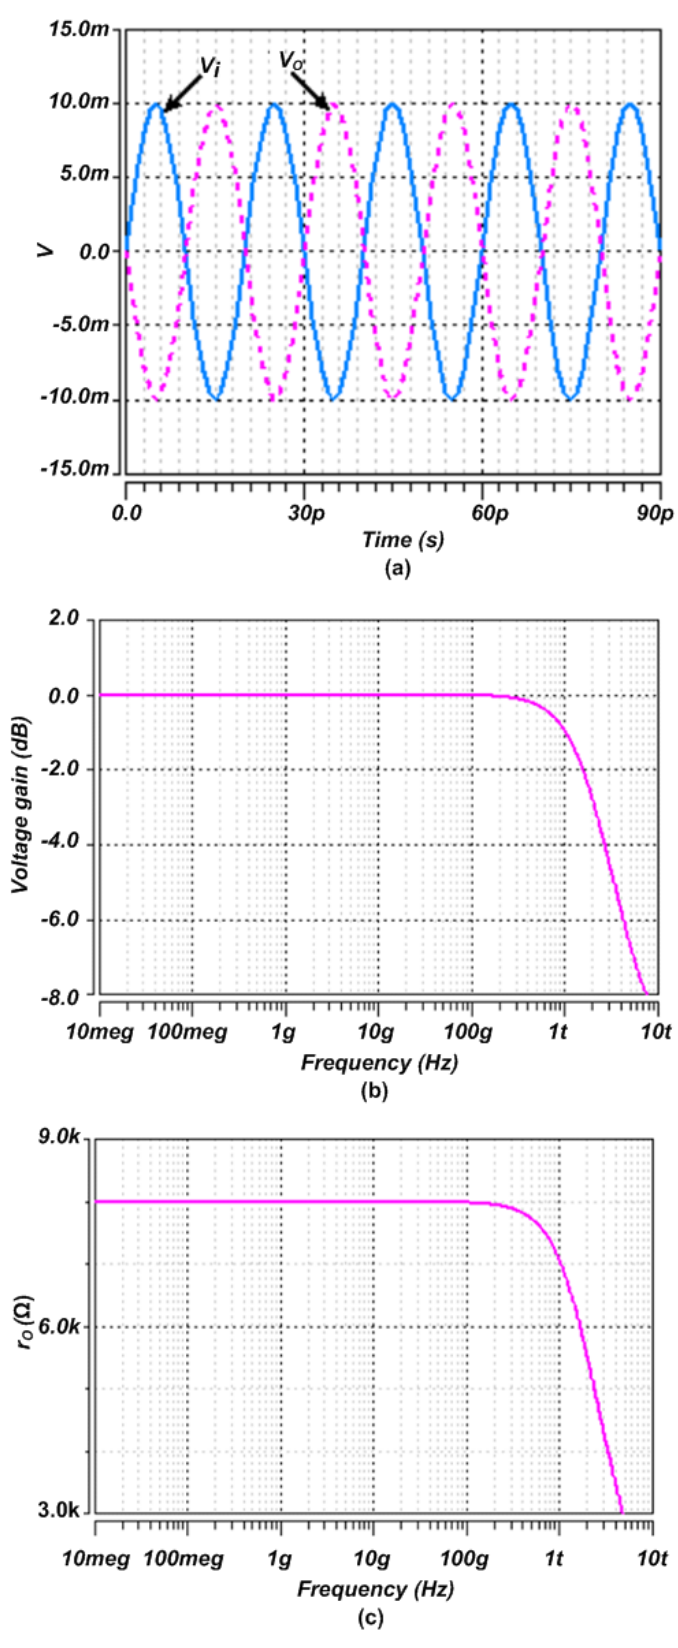
Figure 5. The UGIA: ( a ) Transient-response; ( b ) Frequency-response of Voltage-gain ( V o / V i ); ( c ) Frequency-response of